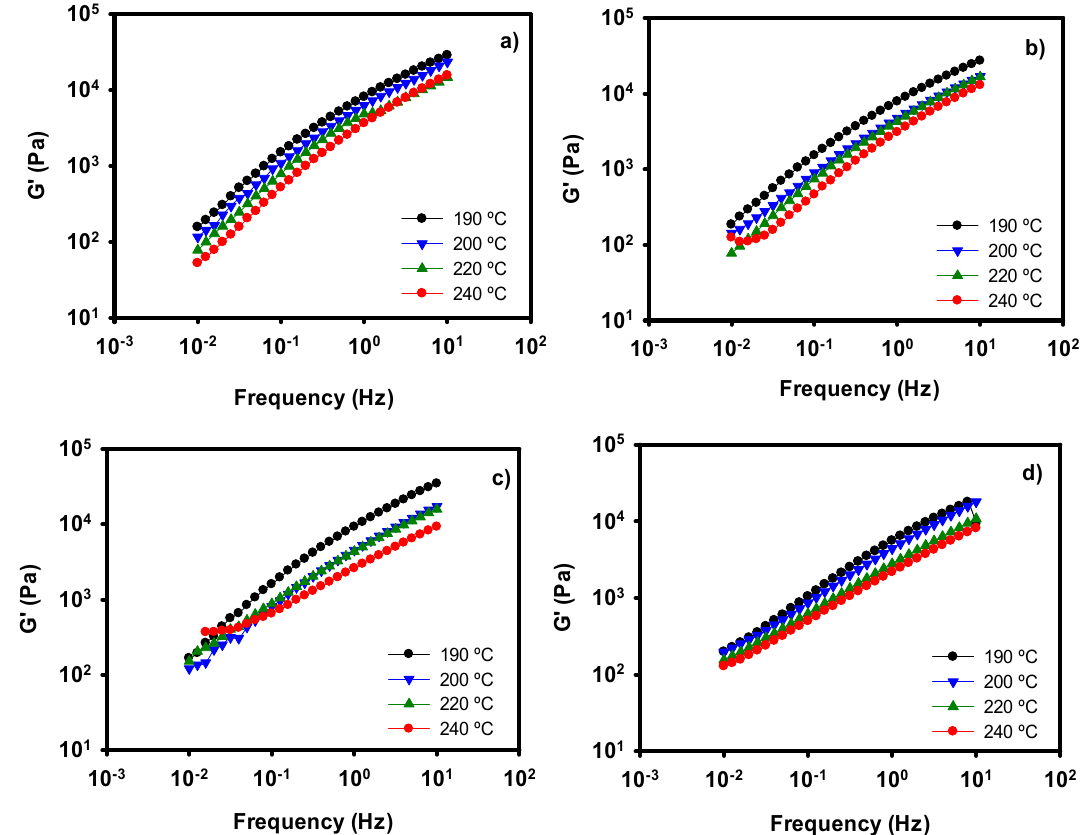
Figure 5. Storage Moduli values at several temperatures of neat PE ( a ), PE with whitening agent ( b ), PE + WA-modified LDH ( c ), and PE + WA-LDH and surfactant ( d